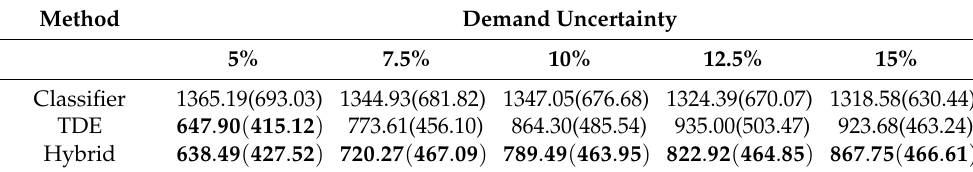
Table 3. Comparing Zone Size in Total Pipe Distance ZPS ( σ ZPS ) .